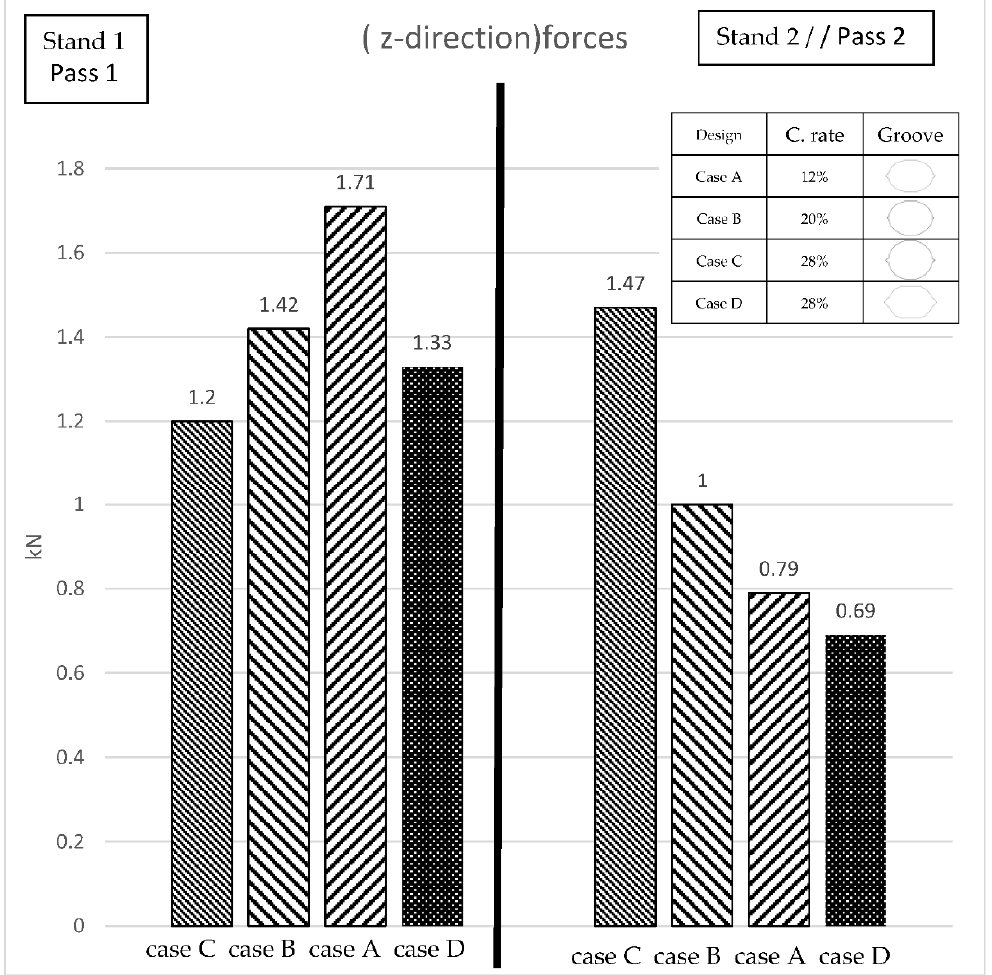
Figure 14. The dragging (z-direction) forces of pass 1 and pass 2.